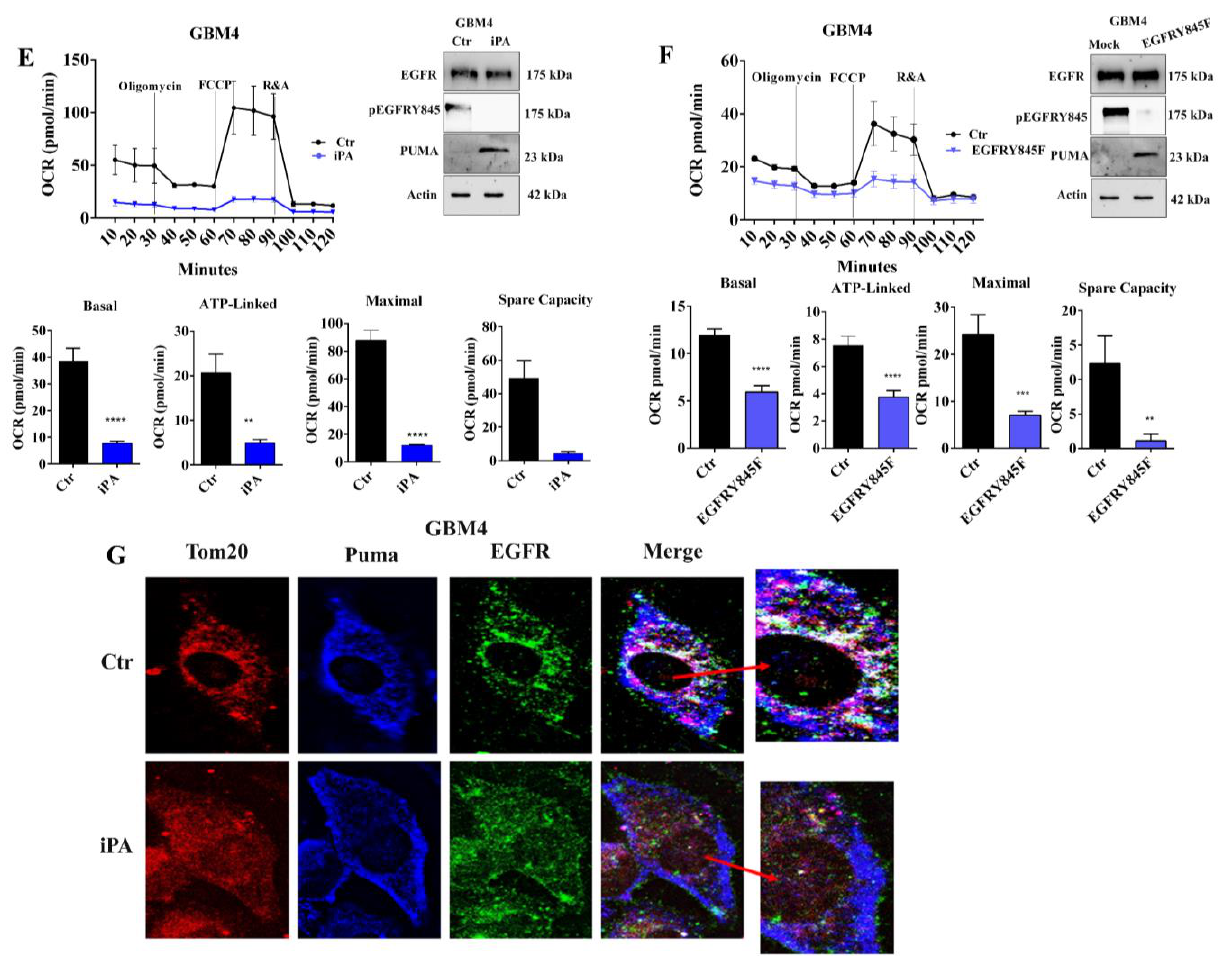
Figure 7. iPa effects on mitochondrial metabolism on primary glioblastoma cells. Left panels of ( A – E ) are the representative OCR showing the inhibitory effect of 10 µ M iPA on mitochondria func- tionality in six primary glioblastoma cell lines (GBM12 to GBM4). On the right of each plot is shown the immunoblotting analysis for the EGFRY845 and PUMA levels. 10 µ M iPA reduced the EGFRY845 levels, while PUMA levels were increased. ( F ) Left : OCR of GBM4 transfected with EGFRY845F or not. Right : western blot analysis showing EGFR and pEGFRY845 protein levels after 10 µ M iPA on GBM4 cells that were or were not transfected with EGFRY845F. ( G ) Immunofluorescence staining of GBM4 cells showing the different localization of EGFR and PUMA after 10 µ M iPA treatment (lower panel). GBM4 cells showed an increased blue signal (PUMA), while in merged images, TOM20 co-localized with PUMA, producing a violet color due to the reduction of the EGFR green signal as compared to Ctr (red arrow indicating the magnification marge image). Data were analyzed for statistical significance using the 2-tailed Student t -test or ANOVA, followed by Bonferroni correction for multiple comparisons. Results are representative of 3 experiments performed in duplicate and are expressed as mean ± SD (ANOVA * p < 0.05; ** p < 0.01; *** p < 0.001,**** p <